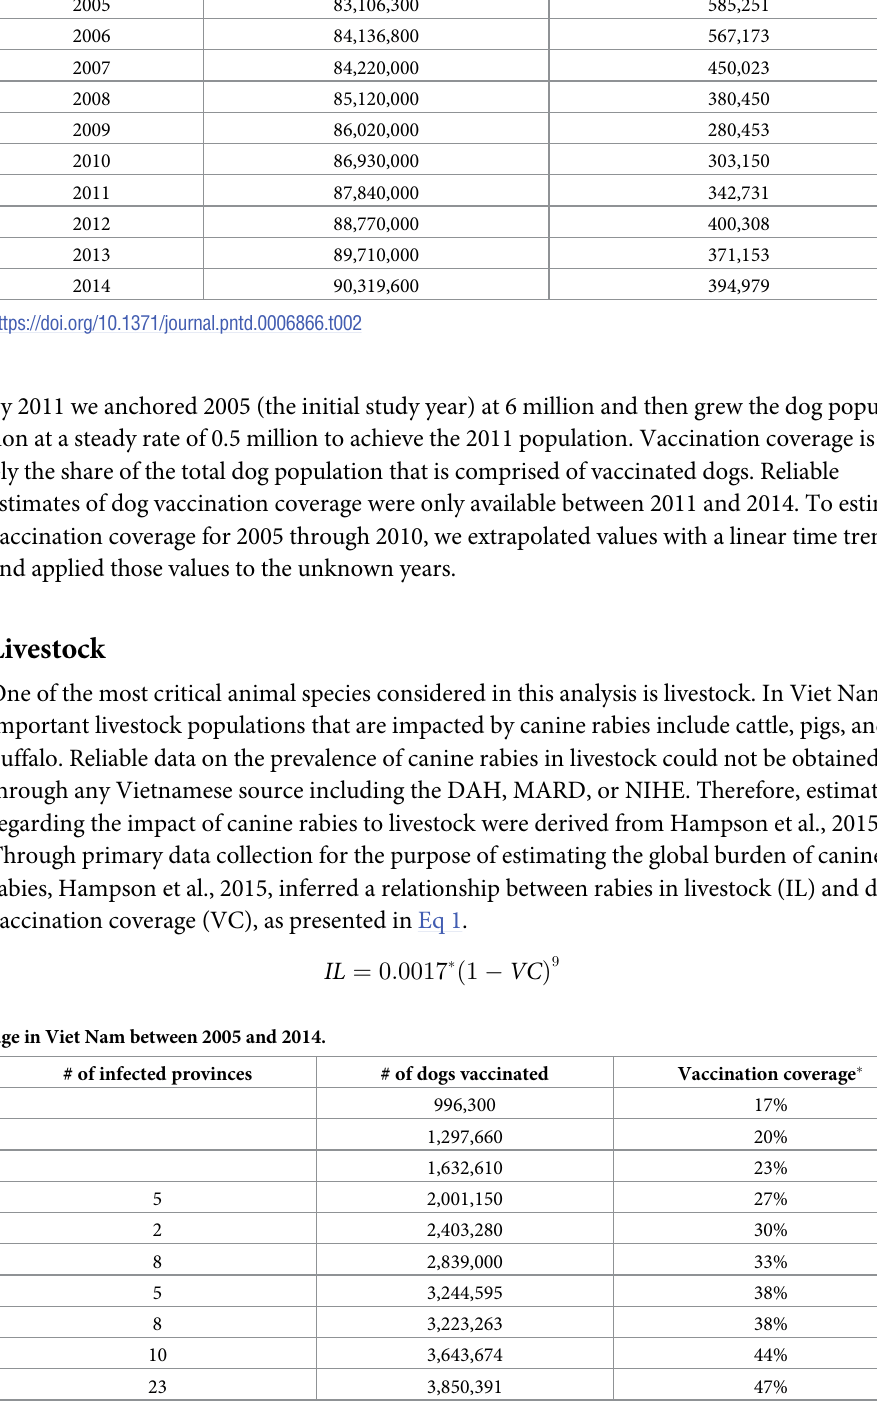
Table 2. Human population and PEPs administered in Viet Nam between 2005 and 2014.